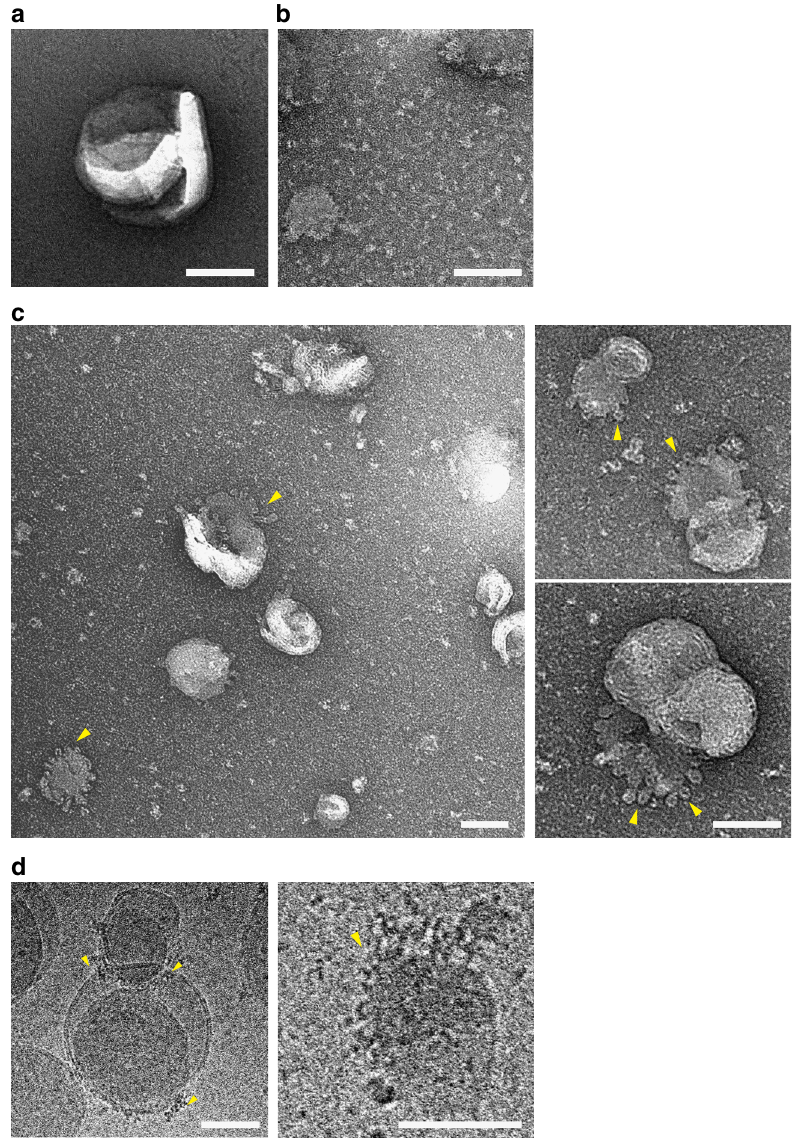
Fig. 5 Electron-microscopic visualization of IFT172 with Folch fraction liposomes. a Negative-stain EM image of Folch fraction I liposomes as control. Scale bar: 100 nm b Negative-stain EM image of IFT172 (1 µ M) with Folch fraction I liposomes (0.2 mM). Scale bar: 100 nm. The membrane became deformed into small pieces. c Negative-stain EM images of IFT172 (250 nM) with Folch fraction I liposomes (0.2 mM) showing the remodeling of the membrane surface by IFT172. Scale bar: 100 nm. Small (~20 nm) vesicles (yellow arrowheads) get pinched off from the membrane surface. d Cryo-EM images of IFT172 (500 nM) with Folch fraction I liposomes (0.4 mM). Scale bar: 100